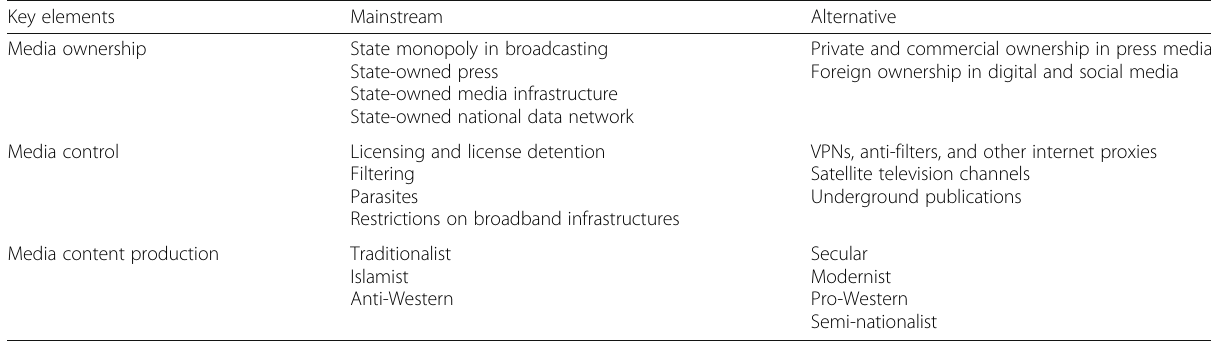
Table 1 Key elements of the relationship between media and politics in the litany layer Key